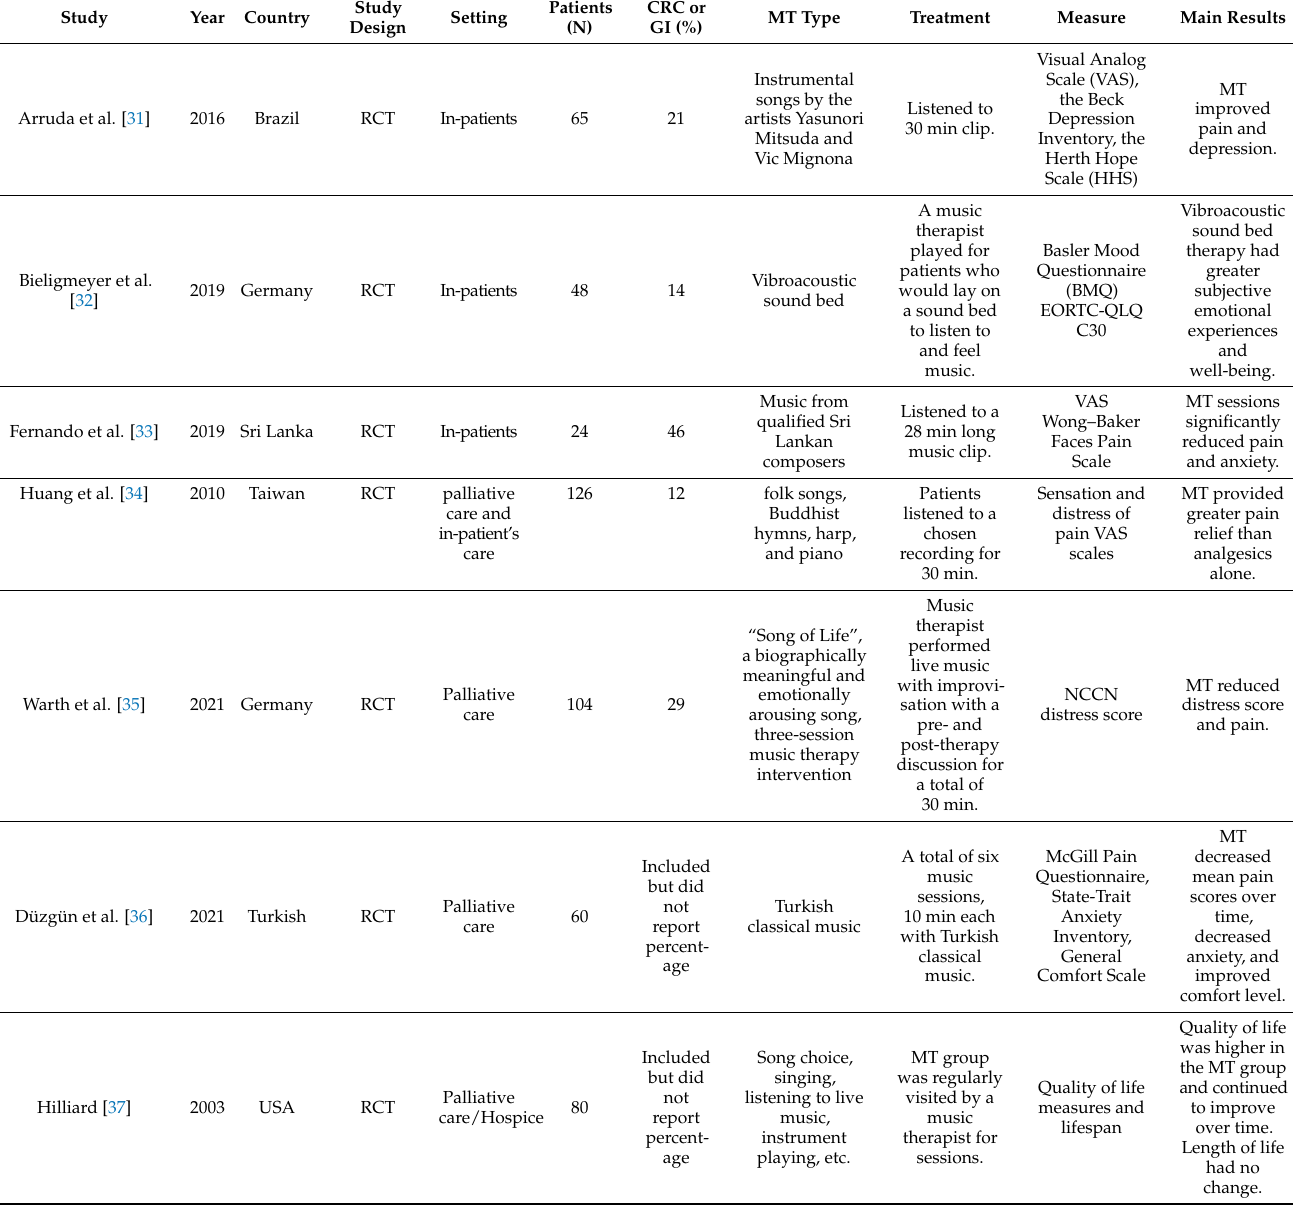
Table 1. Summary of Data Extracted from Relevant